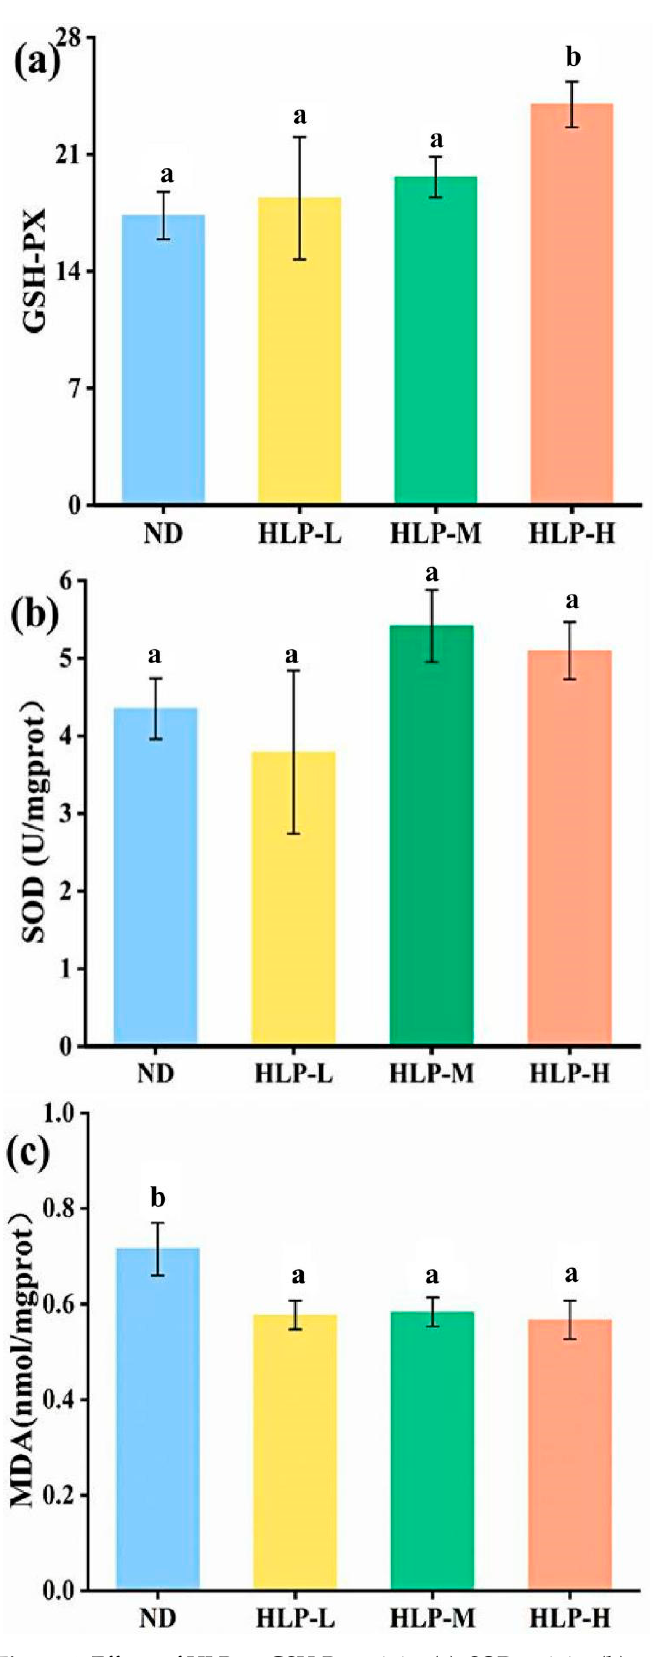
Figure 4. Effects of HLP on GSH-Px activity ( a ), SOD activity ( b ), and MDA content ( c ) in the mouse livers. Values with different letters are significantly different ( p < 0.05).